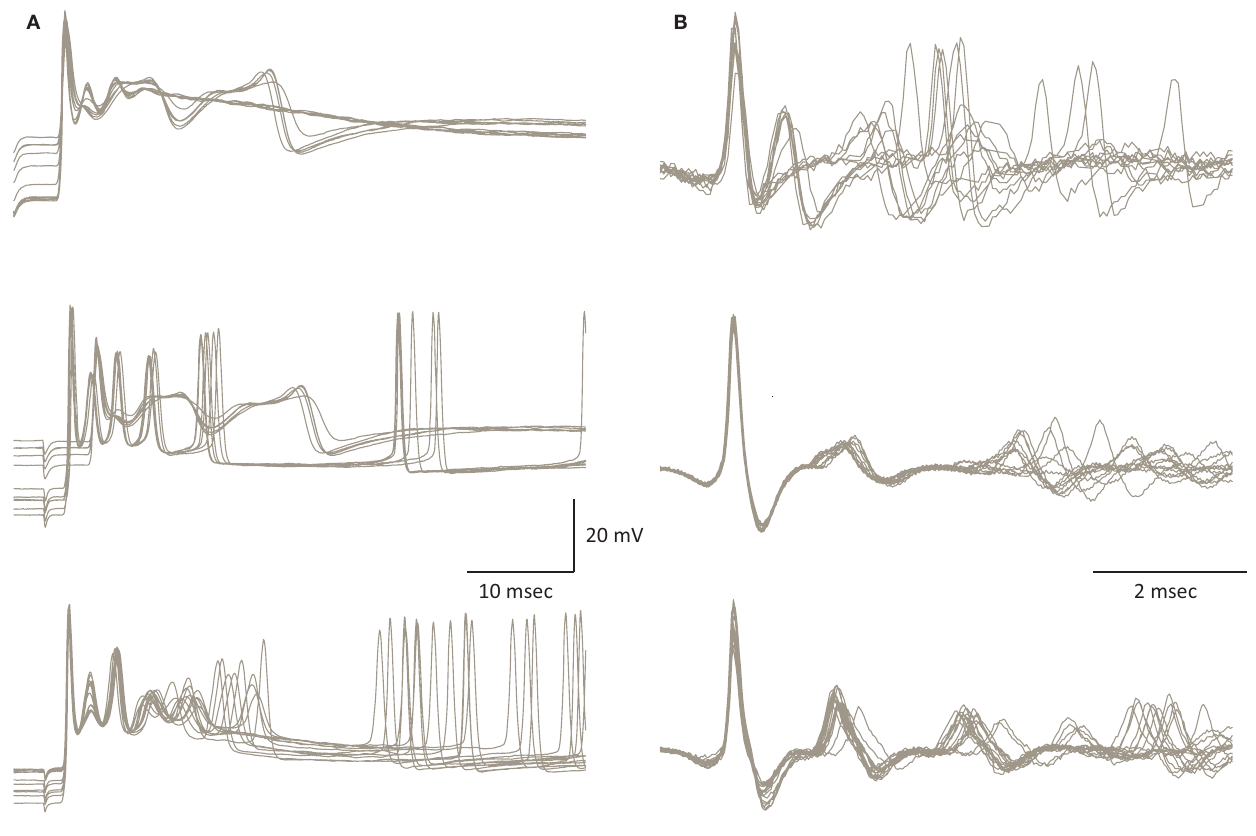
FIGURE 4 | Variability of the CS waveform. (A) Examples of CSs recorded from 3 PCs in slice preparation. The superimposed traces represent CSs that were elicited by stimulating the white matter below the recorded PC. Note the variable waveform and the changes in the resting potential just before the onset